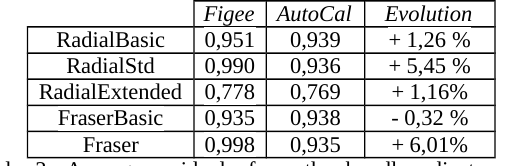
Table 3: Average residuals from the bundle adjustment in different scenarios